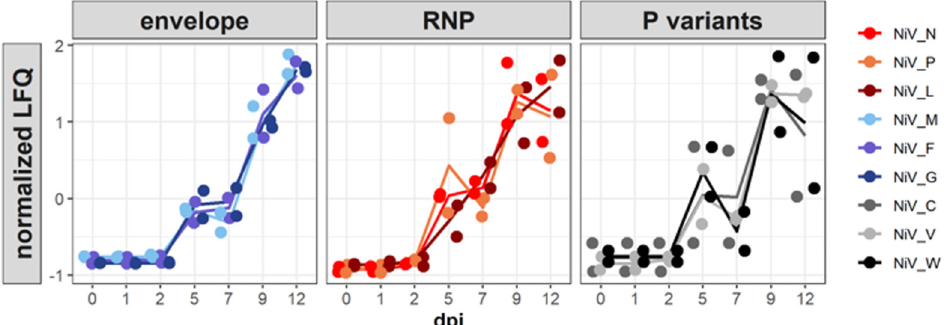
Figure 6. Time course of NiV protein expression. NiV protein levels are shown as normalized values based on label-free quantification. For better visualization, the NiV envelope proteins (M, F, and G), RNP-associated proteins (N, P, and L), and P variants (C, V, and W) are shown in separate panels.